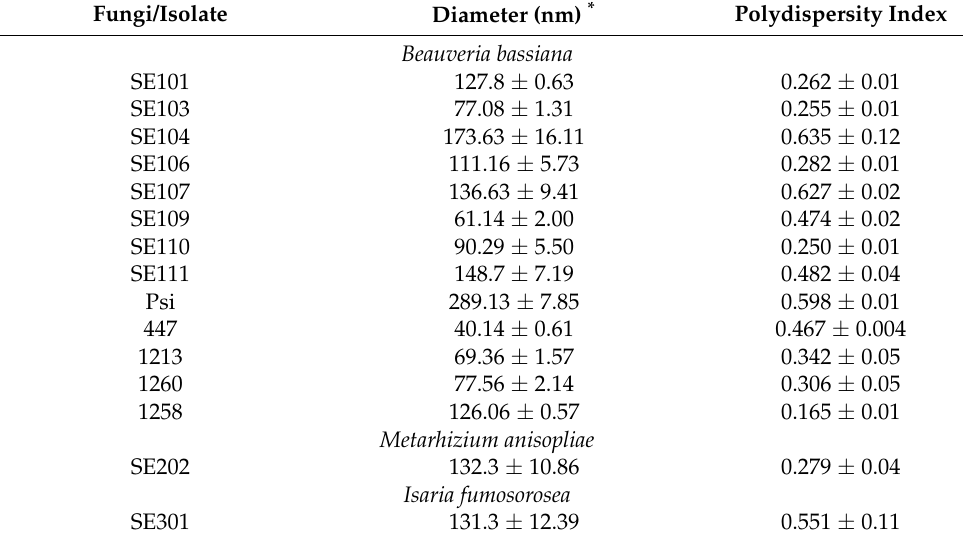
Table 3. Average diameter and polydispersity index of silver nanoparticles synthesized by ento- mopathogenic fungi extracts. Fungi/Isolate Diameter (nm) * Polydispersity Index Beauveria bassiana